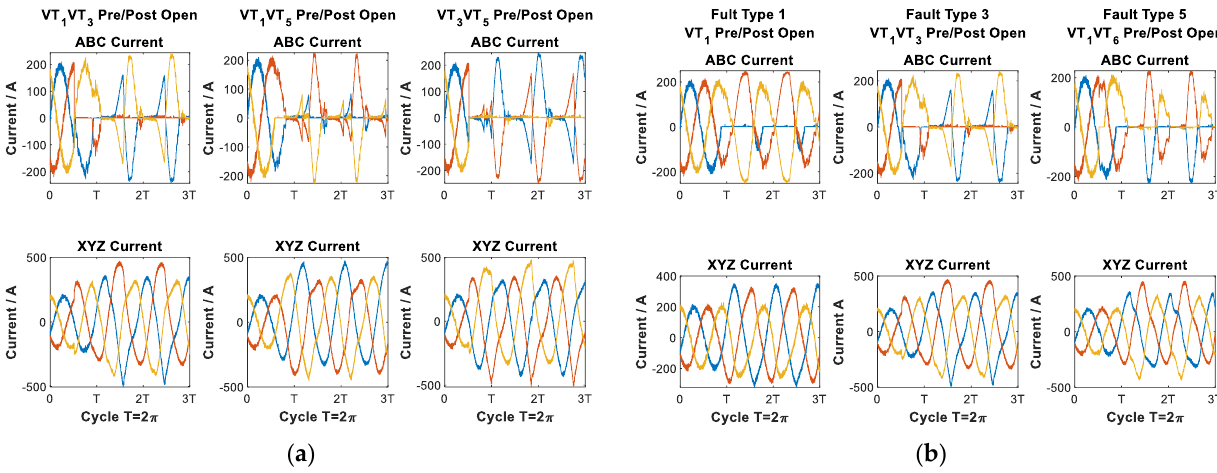
Figure 4. Six-Phase Current Variation of Electric Propulsion System Before and After Fault: ( a ) Same Fault Type; ( b ) Different Fault Types.